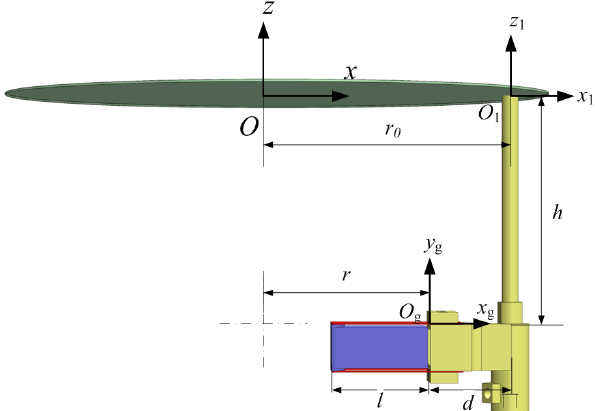
Figure 6. Structure of a leaf